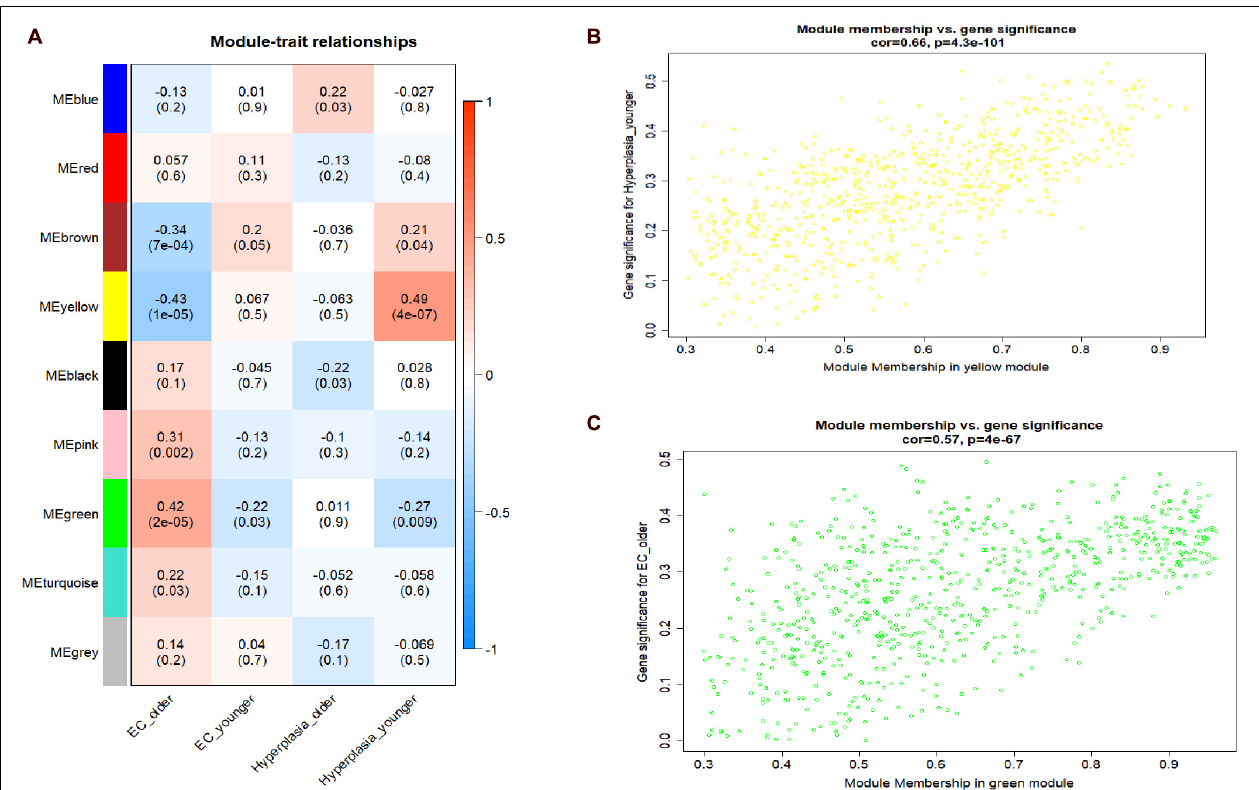
FIGURE 3 | Module-trait relationships plot and scatterplot of gene significance vs. module membership. (A) Module-trait relationships plot. Each row represents a module eigengene, each column represents a clinical trait, and each cell consists of the corresponding correlation and p value, which are color-coded by correlation according to the color legend. (B) Scatterplot of gene significance ( y -axis) vs. module membership ( x -axis) in yellow modules. (C) Scatterplot of gene significance ( y -axis) vs. module membership ( x -axis) in yellow and green